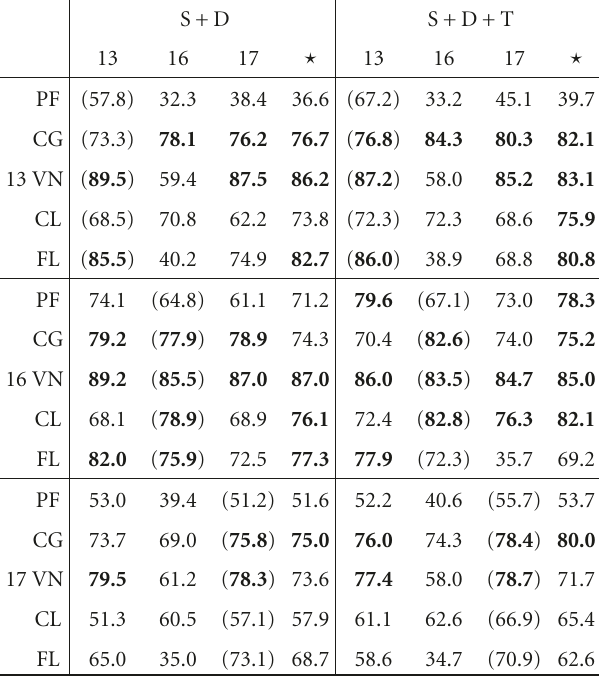
Table 8: Template construction from only one piece (Experiment 2). Quartet only due to lack of space (unit: %).